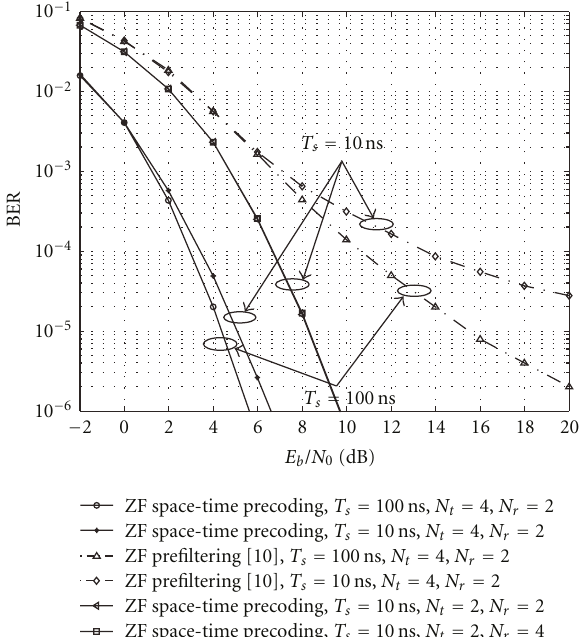
Figure 3: BER performance comparison between the proposed ZF- based space-time precoding for TR-MIMO-UWB system and ZF- based prefiltering scheme.